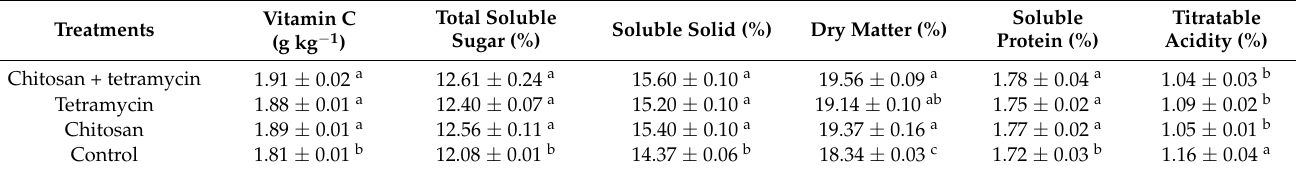
Values indicate the mean ± SD of three replicates. Small letters indicate significant differences at 5% level ( p <